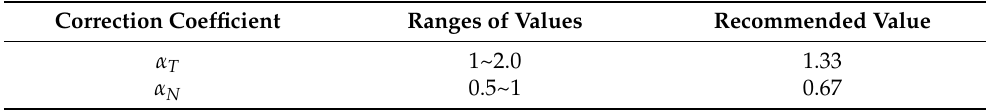
Table 3. The values of correction coefficients α T and α N